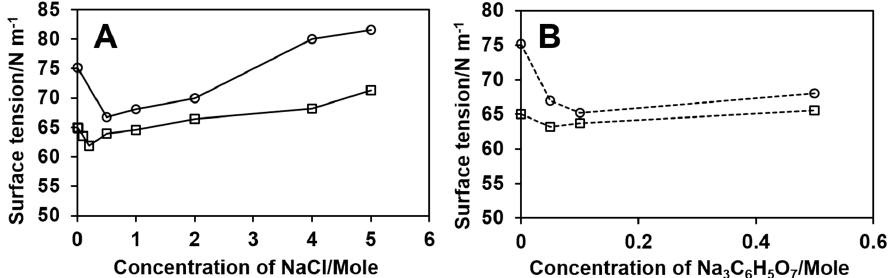
Figure 6. Surface tension of PUL solutions 8% PUL ( □ ) and 15% PUL ( ○ ) with different NaCl ( A ) and Na 3 C6H 5 O 7 ( B ) content.